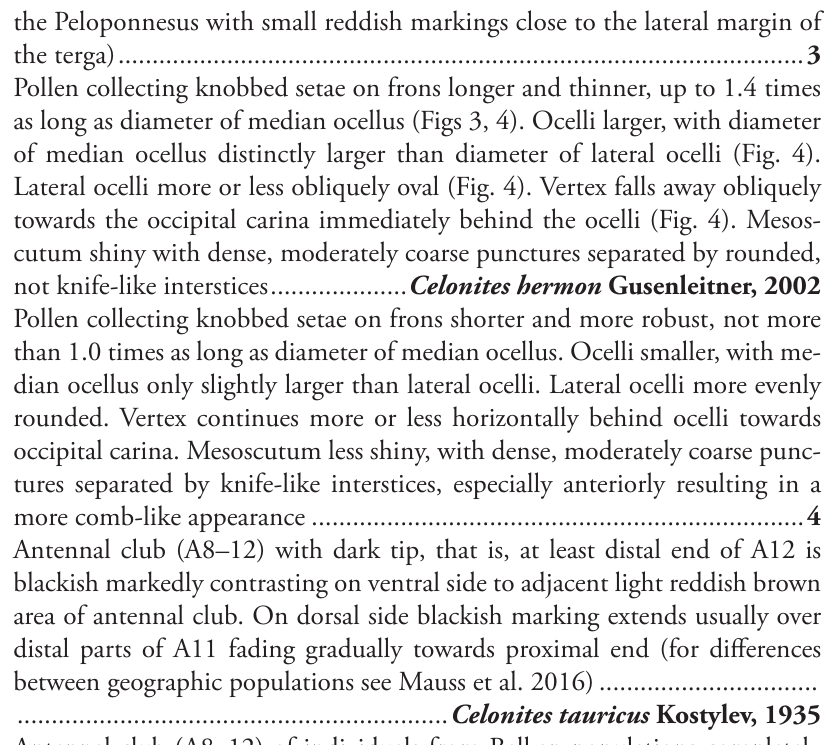
the Peloponnesus with small reddish markings close to the lateral margin of the terga) ..................................................................................................... 3 3 Pollen collecting knobbed setae on frons longer and thinner, up to 1.4 times as long as diameter of median ocellus (Figs 3, 4). Ocelli larger, with diameter of median ocellus distinctly larger than diameter of lateral ocelli (Fig. 4). Lateral ocelli more or less obliquely oval (Fig. 4). Vertex falls away obliquely towards the occipital carina immediately behind the ocelli (Fig. 4). Mesos- cutum shiny with dense, moderately coarse punctures separated by rounded, not knife-like interstices .................... Celonites hermon Gusenleitner, 2002 – Pollen collecting knobbed setae on frons shorter and more robust, not more than 1.0 times as long as diameter of median ocellus. Ocelli smaller, with me- dian ocellus only slightly larger than lateral ocelli. Lateral ocelli more evenly rounded. Vertex continues more or less horizontally behind ocelli towards occipital carina. Mesoscutum less shiny, with dense, moderately coarse punc- tures separated by knife-like interstices, especially anteriorly resulting in a more comb-like appearance ........................................................................ 4 4 Antennal club (A8–12) with dark tip, that is, at least distal end of A12 is blackish markedly contrasting on ventral side to adjacent light reddish brown area of antennal club. On dorsal side blackish marking extends usually over distal parts of A11 fading gradually towards proximal end (for differences between geographic populations see Mauss et al. 2016) ................................ ............................................................... Celonites tauricus Kostylev, 1935 – Antennal club (A8–12) of individuals from Balkan populations completely orange, in some dark coloured individuals from western populations club becomes darker dorsally, while immediate tip and especially ventral side of A12 remain lighter ............................ Celonites abbreviatus (Villers, 1789) 5 Tergum VII trilobed. Posterior emargination of sternum VIII medially bent at an angle of about 135°. Laterally the posterior, angled margin of sternum VIII continues directly into the lateral surface of the sternum without a prominent edge or a distinct spine, so that even a small postero-lateral trans- verse section is lacking. Genitalia as in Mauss 2013: fig. 26. Metasoma black with extensive yellowish-white and reddish markings .................................... ..................................................... Celonites andreasmuelleri Mauss, 2013 – Tergum VII quadrilobed, since the median lobe is medially distinctly emar- ginate (Fig. 6). Sternum VIII different, with a distinct little spine on each side of the posterior margin (Fig. 8). Genitalia different. Metasoma black with extensive yellowish-white or yellow but without reddish markings (excep- tion being made for C. abbreviatus from the Peloponnesus with small reddish tinges close to the lateral margins of the terga) ............................................ 6 6 Posterior margin of stipes of male genitalia with dorso-medial concavity (Figs 9, 10). Stipes in dorsal view elongated, with medial and lateral margin running more or less parallel towards posterior end (Figs 9, 10). Posterior process of volsella conically rounded. Medial process of volsella set off